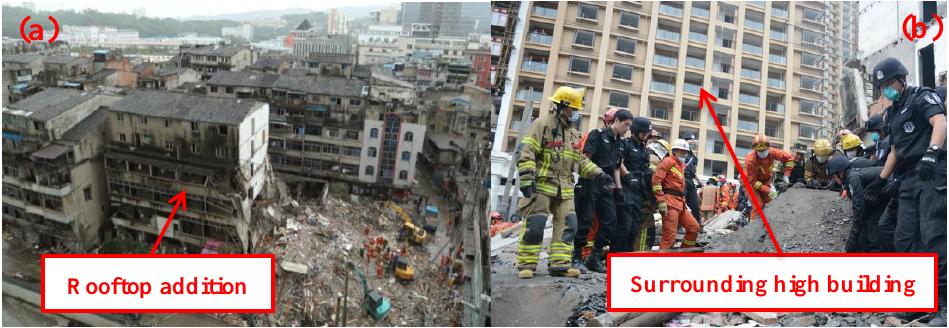
Figure 4. Scene of collapsed incident on 10 October, 2016: (a) rooftop addition of collapsed building; (b) surrounding high building in collapsed site.